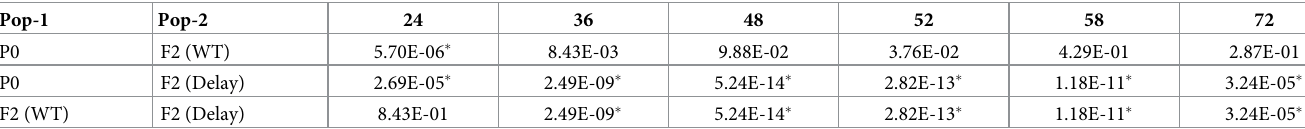
Table 1. Statistical comparisons of F2 hybrid